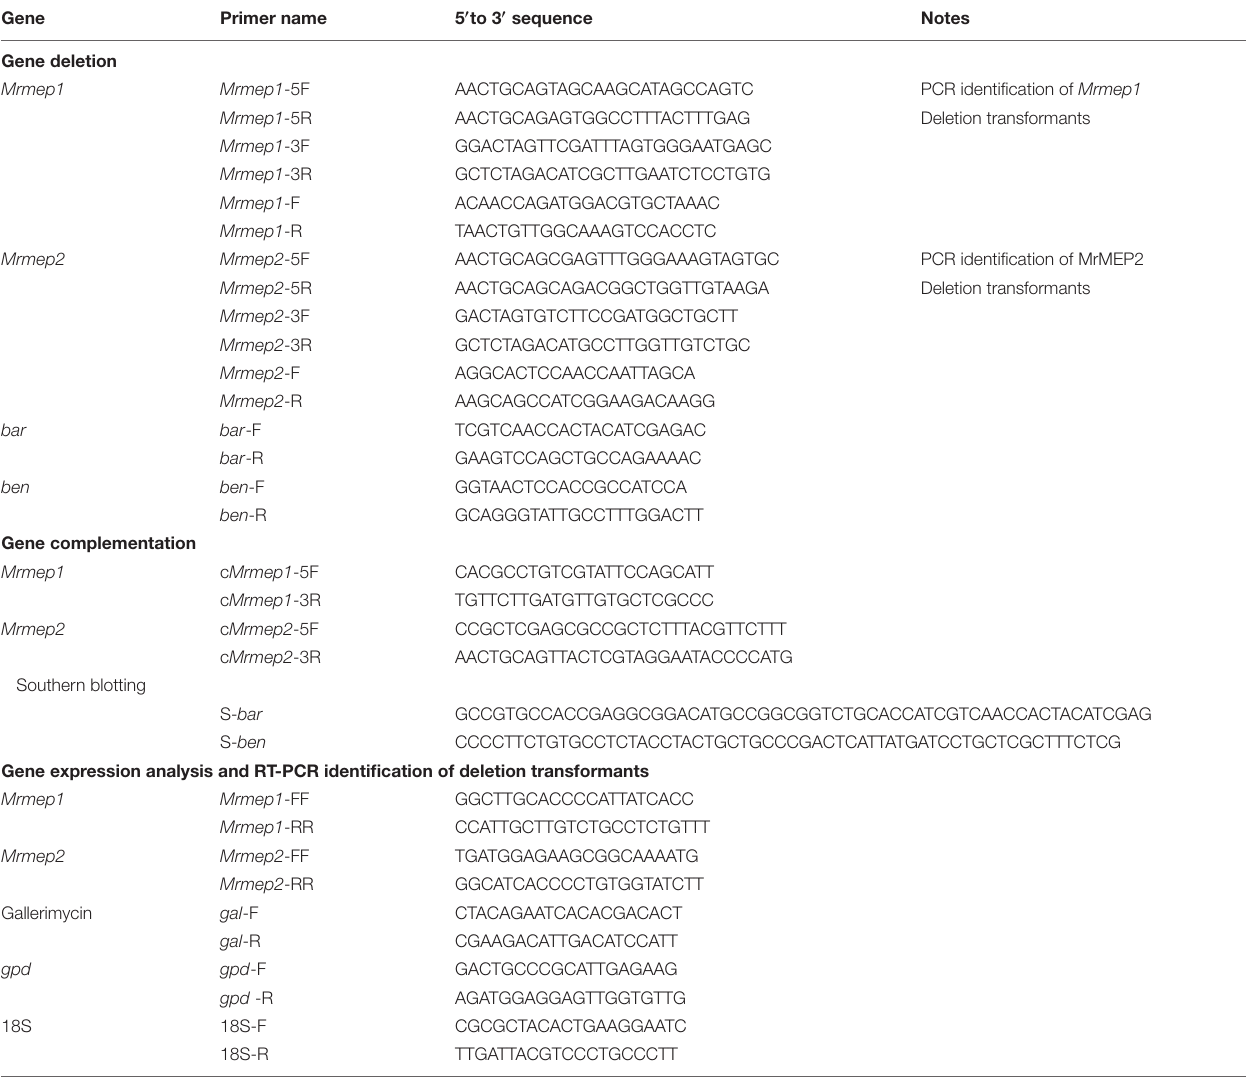
TABLE 1 | Sequences of primers